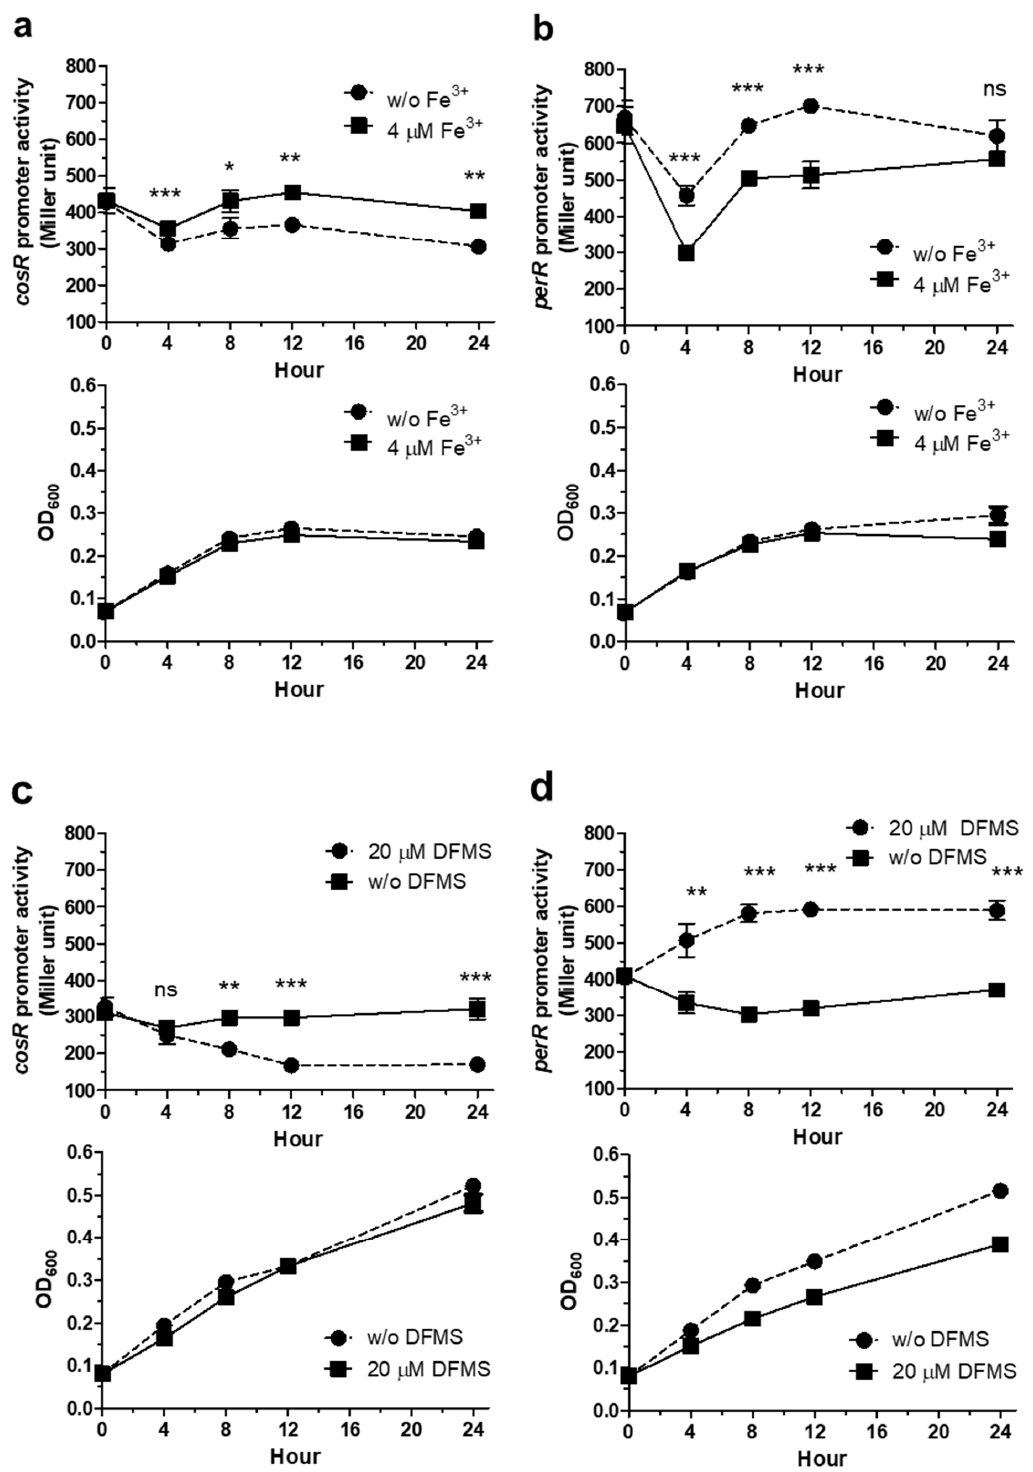
Figure 3. Effects of iron on the transcription of cosR and perR over the growth of C. jejuni . The P cosR :: lacZ and P perR :: lacZ fusion assays were conducted in the presence and absence of iron in MEM α and MH media: ( a ) P cosR :: lacZ assay in MEM α . ( b ) P perR :: lacZ in MEM α . ( c ) P cosR :: lacZ assay in MH. ( d ) P perR :: lacZ in MH. Deferoxamine mesylate (DFMS) was used as an iron chelator in MH media. The growth of C. jejuni is indicated with the optical density at 600 nm (OD 600 ) in each panel. The experiment was repeated three times, and similar patterns of results were obtained in the experiments. The statistical analysis was performed using Student’s t -test by comparing the samples with and without iron at the same sampling point. *: p < 0.05, **: p < 0.01, ***: p <